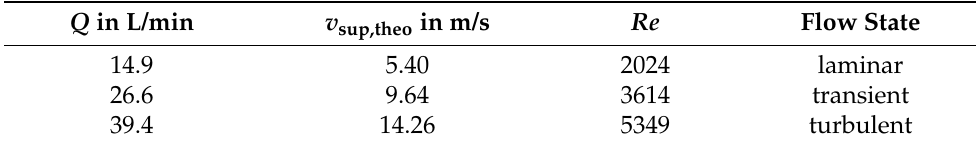
Table 1. Experimental parameter for the volume flow Q , theoretical flow velocity v sup,theo , Reynolds number Re and expected flow state for measurements on the supply flow with nozzle width of w = 20 mm and height of h = 2.3 mm.